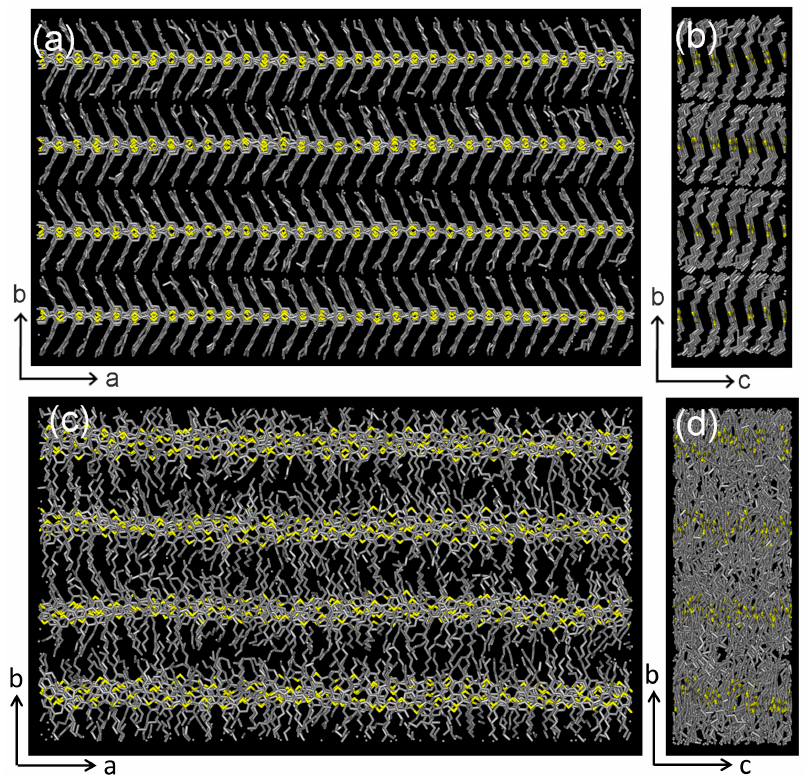
Figure 5. Top view ( a ) and side view ( b ) of the simulation snapshots for rg-P3HT chains; top view ( c ) and side view ( d ) of the simulation snapshots for ra-P3HT chains. The hydrogen atoms are not shown.